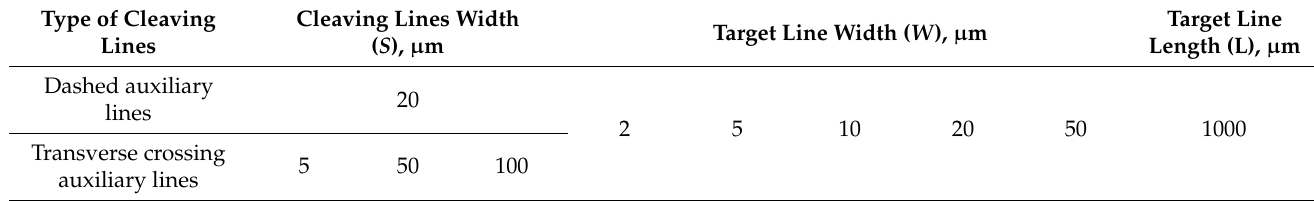
Table 2. Description of the test structure dimensions.